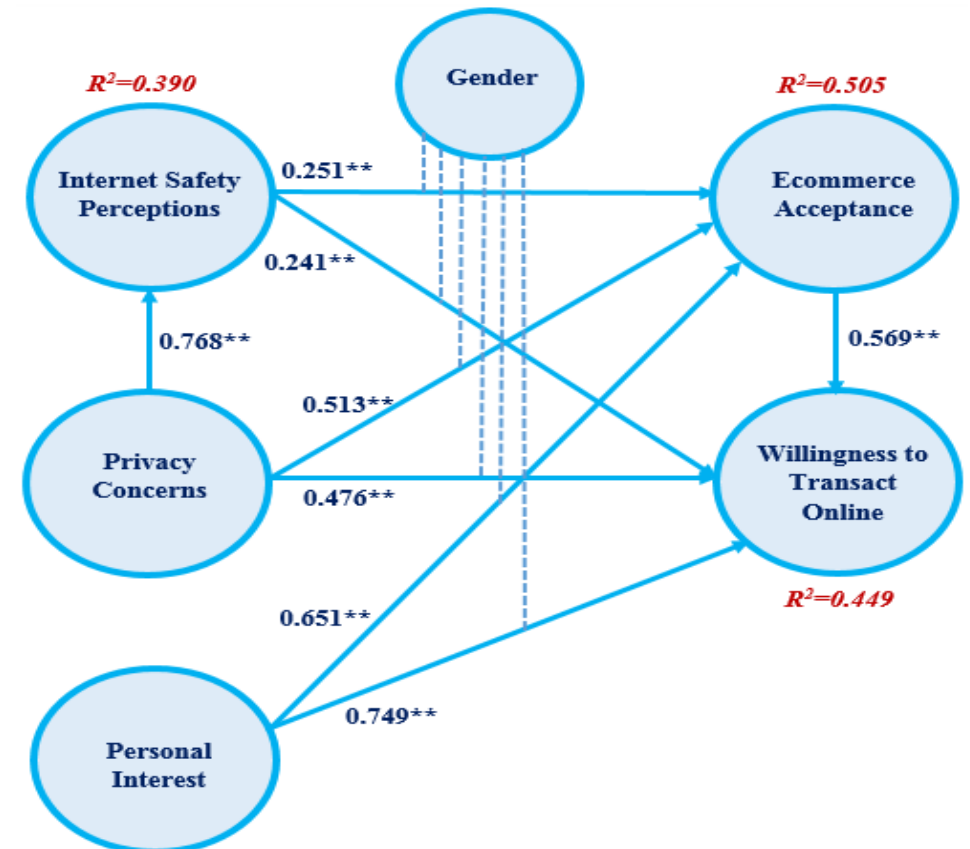
Figure 3. Path coefficient of the model (significant at p ** < = 0.01, p * < 0.05).